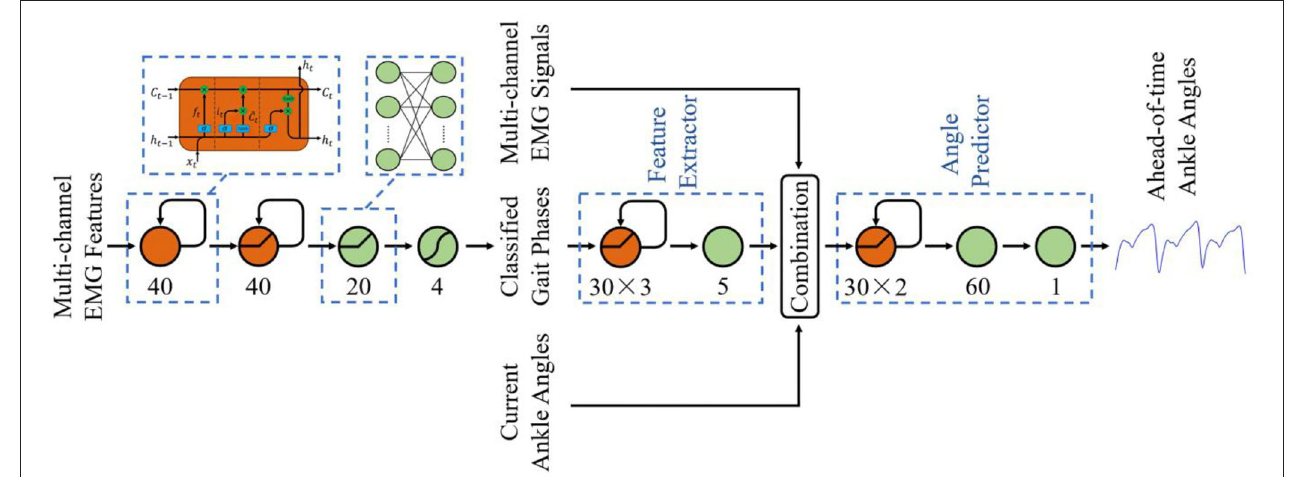
FIGURE 5 | The structure of the phase classifier and ankle angle